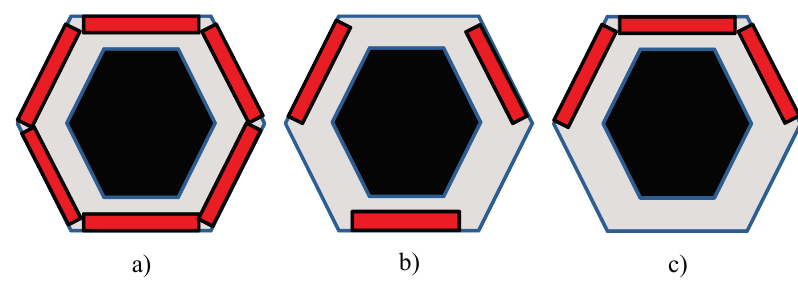
Figure 17. Schematic configurations of the peripheral heaters in the plan view of the plate: ( a ) Hexagonal; ( b ) Triangular; ( c ) One-side. From Carlomagno et al .